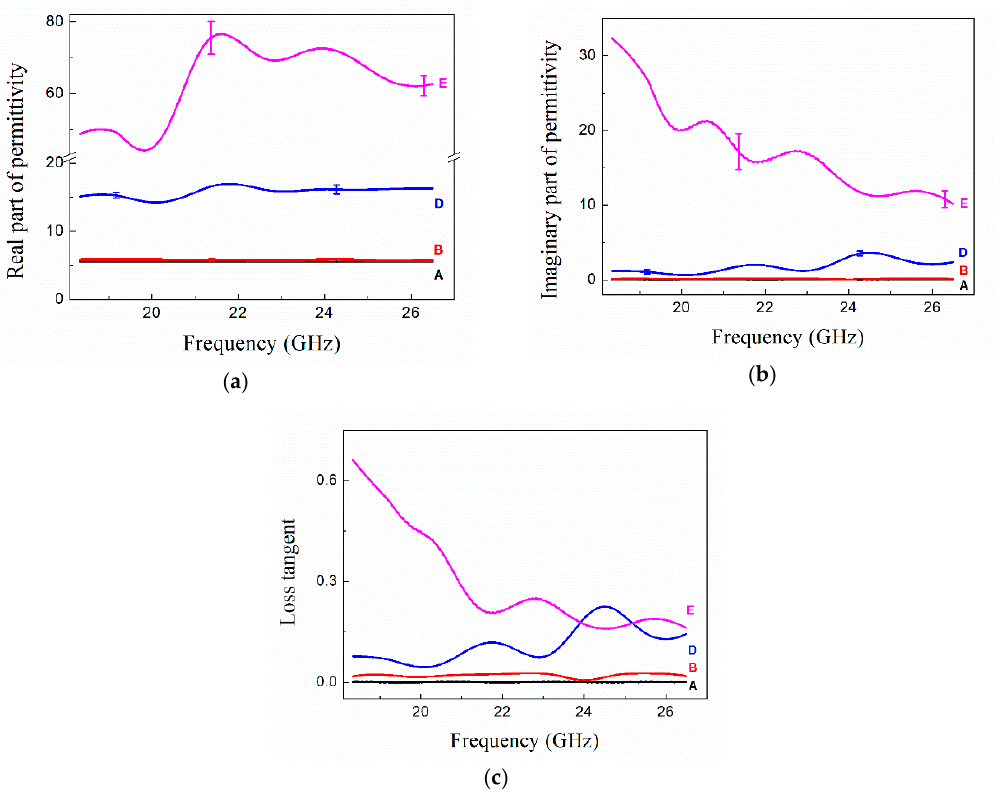
Figure 6. Real part ( a ) and imaginary part ( b ) of permittivity and loss tangent ( c ) of diamond films in the K-band.